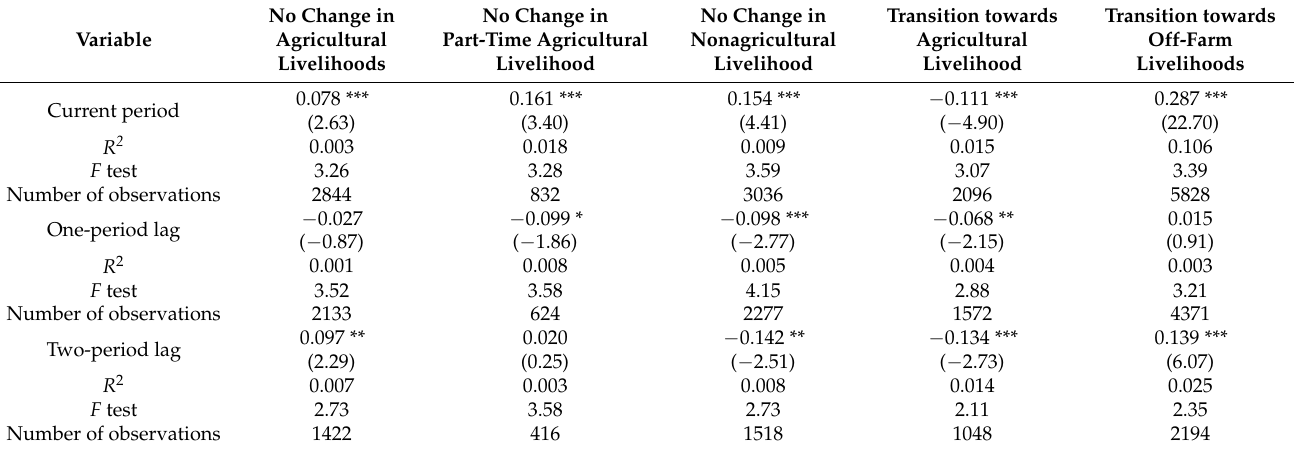
Table 6. The lag effect of household livelihood strategy changes on agricultural